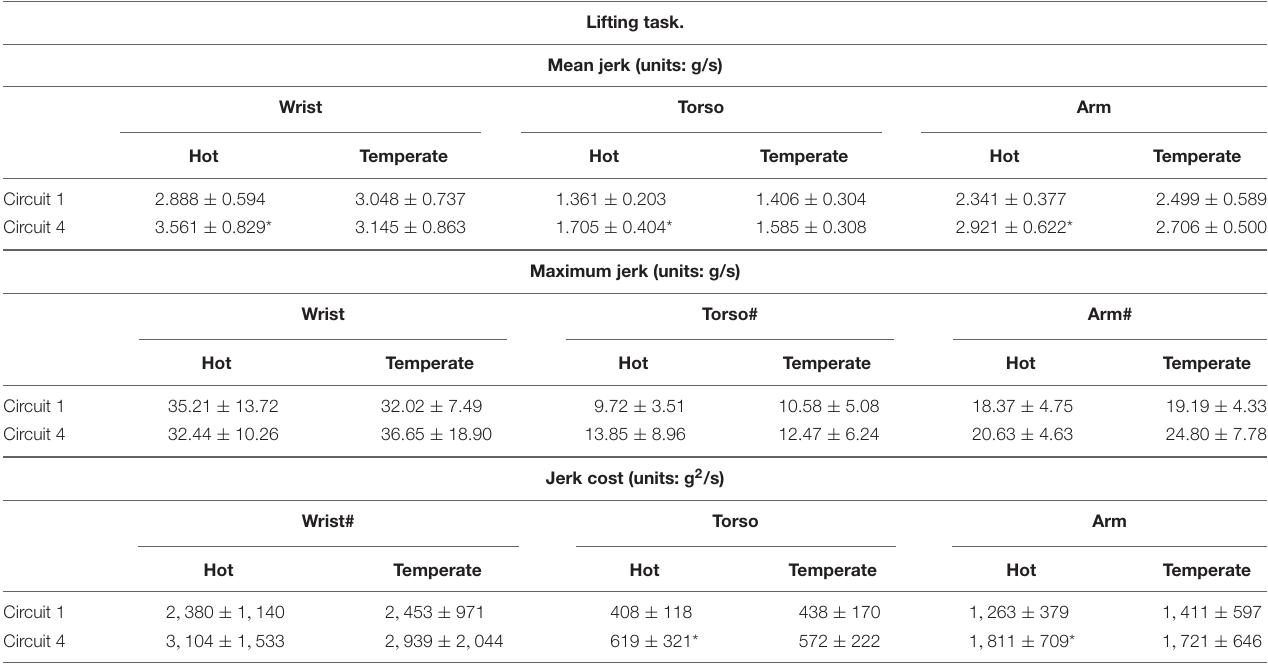
TABLE 3 | Jerk measures measured during a lifting task during the first and fourth bout of work.